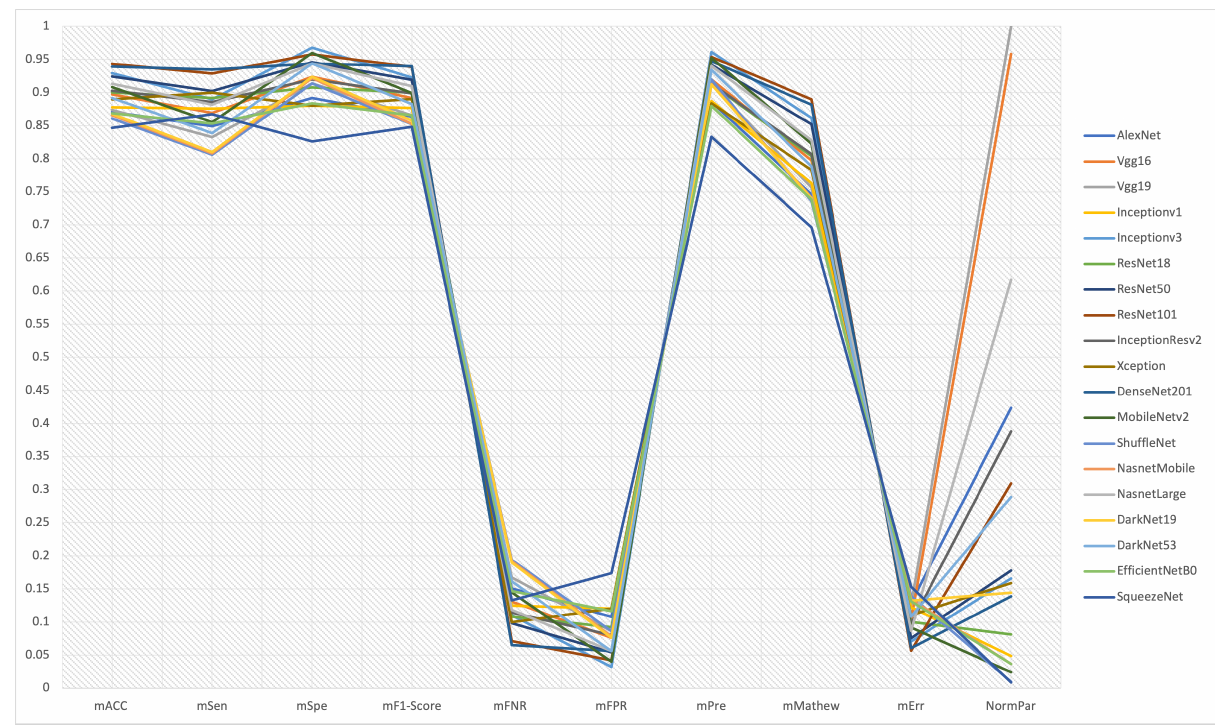
Figure 4. The mean value over the five folds for specific evaluation criteria, along with the number of parameters (the network complexity). No single model achieves the best performance in all evaluation criteria. If a CNN model achieves the best evaluation performance in some evaluation criteria, it may fail to gain superior performance in the remaining